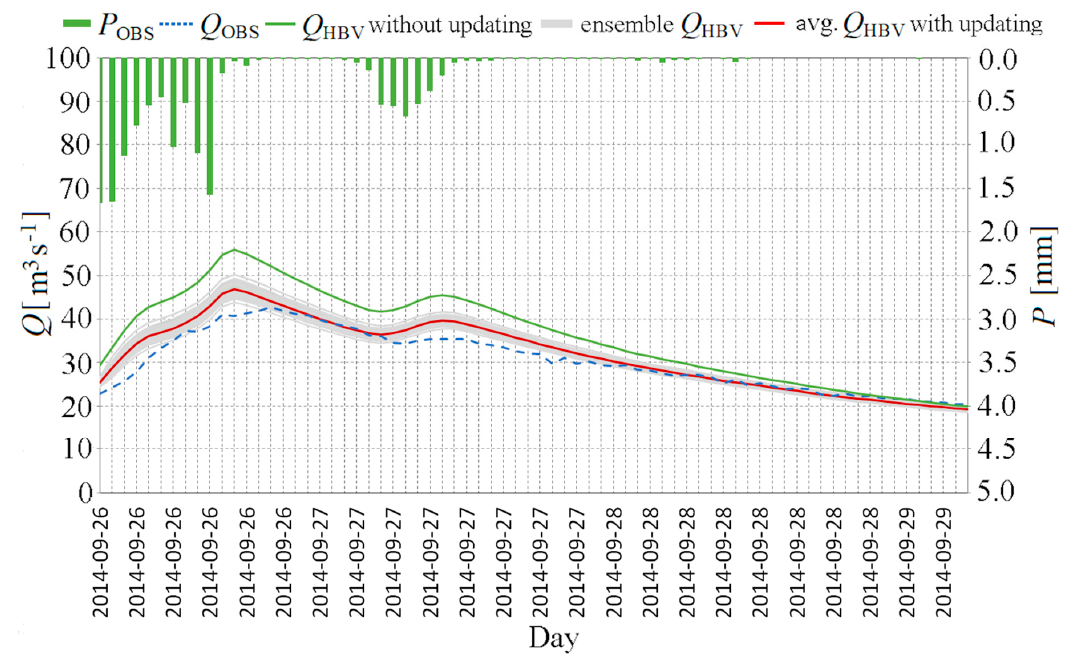
Figure 8. The comparison of Q OBS (observed flow; blue dotted line), Q HBV (HBV product without updating; solid green line), avg. Q HBV with updating (averaged HBV product; solid red line) with updating ( P BC and assimilation of H 1.00 using EnKF-BC) for P OBS (green bar), and ensemble Q HBV (HBV product with updating; solid gray lines) in the Sola Basin at Zywiec, obtained for simulation of the HBV model in forecast mode in the period from 06:00H,26 September 2014 to 06:00H, 29 September 2014 (72 hours).